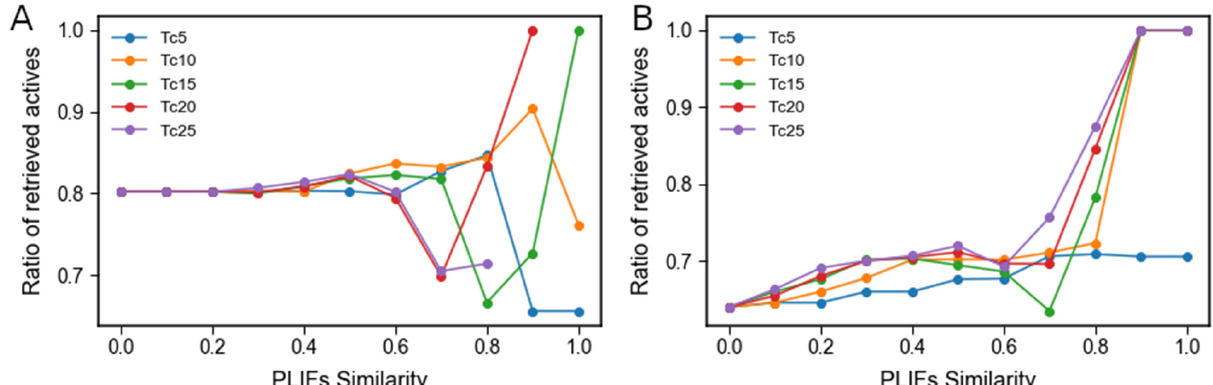
Figure 10. Plots of the enrichment curves calculated using the similarity of residue contacts between the ligands docked poses and the X-ray ligand. The curves are labeled in the plots as “TcN” where “Tc” refers to the Tanimoto coefficient which was the similarity function applied to the PLIFs profiles, and “N” is replaced by the amount of top N most frequent contacts observed in the ChEMBL datasets screened; ( A ) enrichment curves for the EZH2 inhibitors dataset, among which the yellow curve (using 10 residues) was selected to filter new predicted EZH2 inhibitors among known P20S inhibitors; and ( B ) enrichment curves for the P20S inhibitors dataset, among which the red curve (using 20 residues) was selected to filter new predicted P20S inhibitors among known EZH2 inhibitors.